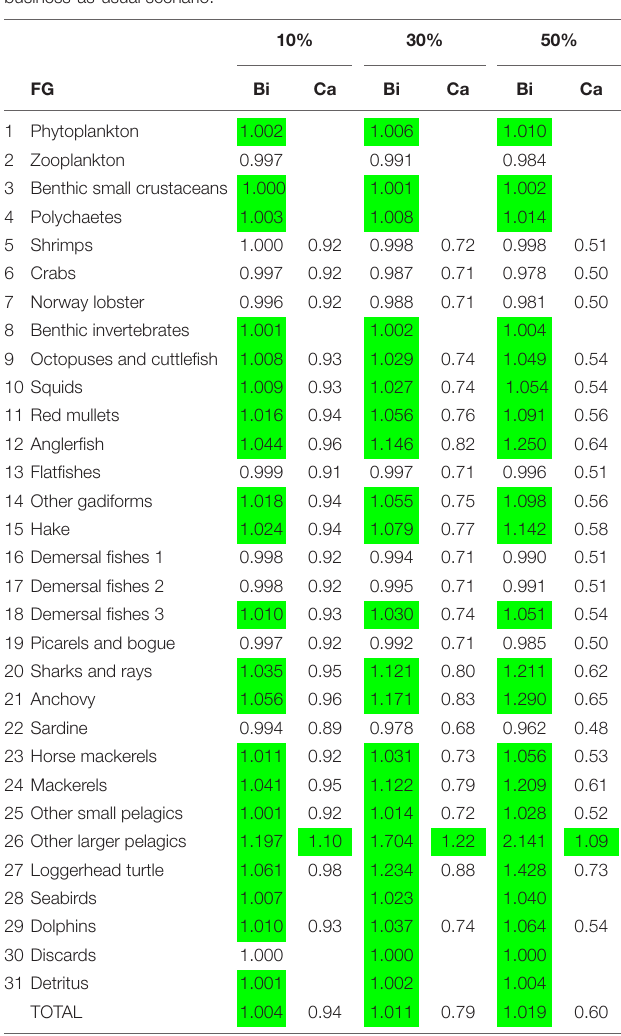
TABLE 7 | Ecosim simulation results for Pagasitikos Gulf for three scenarios of fishing effort reduction by 10, 30, and 50% compared to the business-as-usual